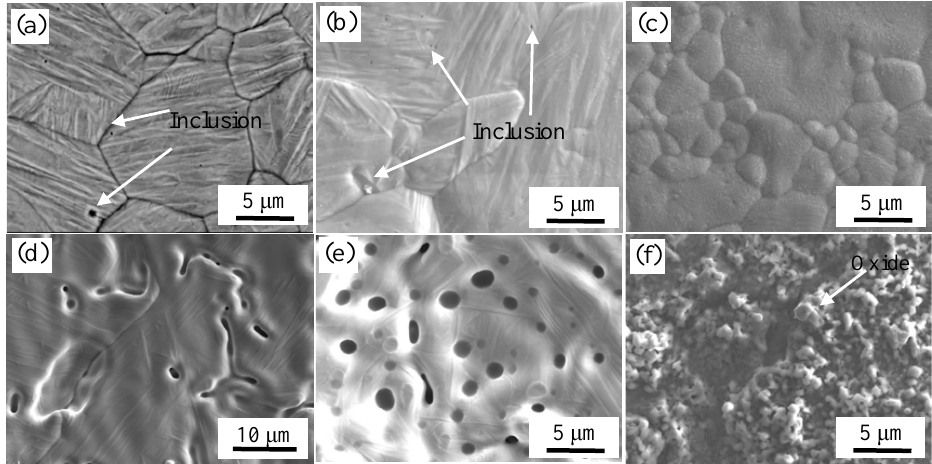
Figure 12. High temperature oxidation images of steel surface at different vacuum degree. At 10 –2 Pa: ( a ) carbon steel and ( d ) stainless steel; at 1 Pa: ( b ) carbon steel and ( e ) stainless steel; and at 10 5 Pa: ( c ) carbon steel and ( f ) stainless